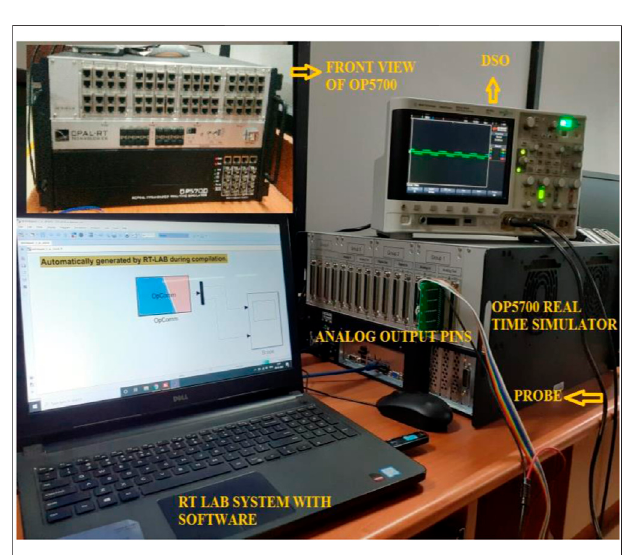
FIGURE 8 | Real-time setup using